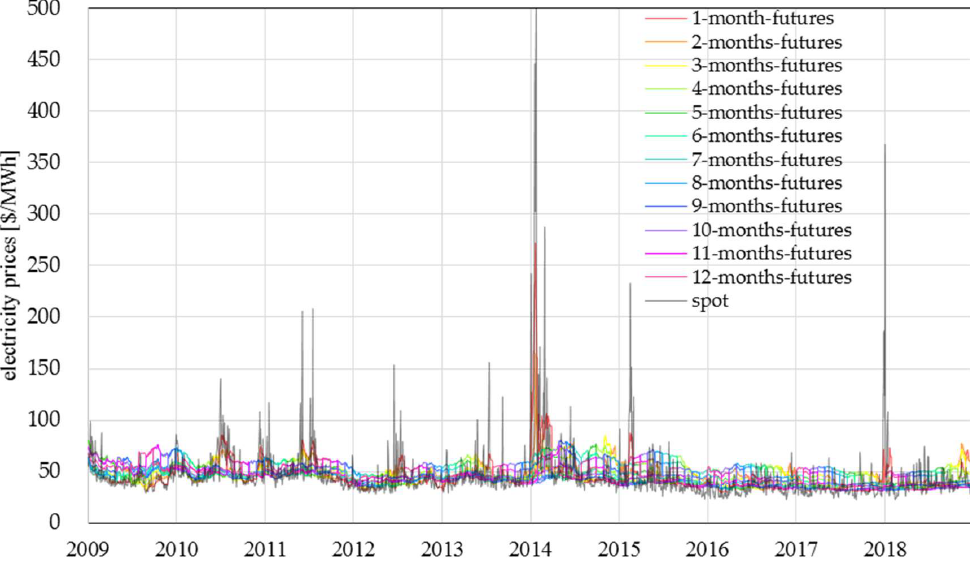
Figure 2. Time series plots of electricity prices. ( n -months-futures signifies futures with n months maturity).